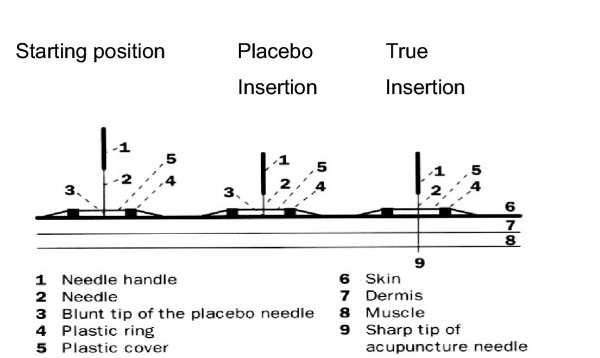
Placebo needle insertion